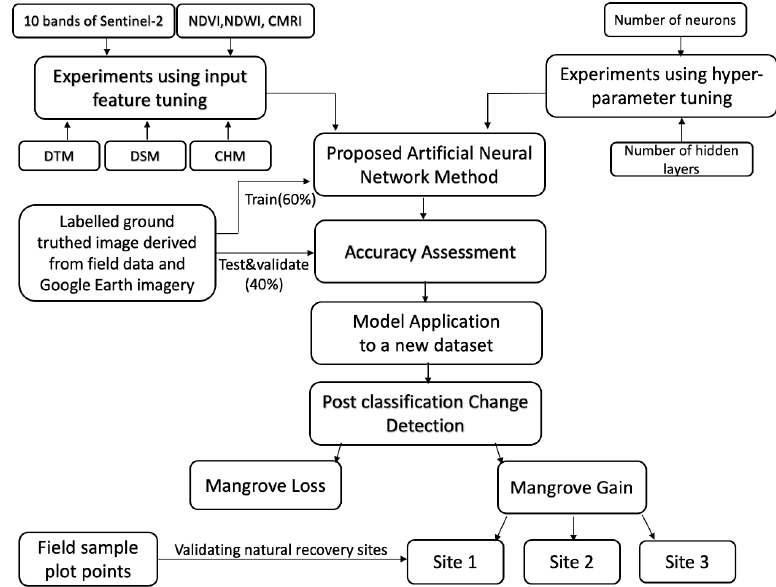
Figure 5. Workflow of assessment of natural recovering mangrove at different abandoned sites.